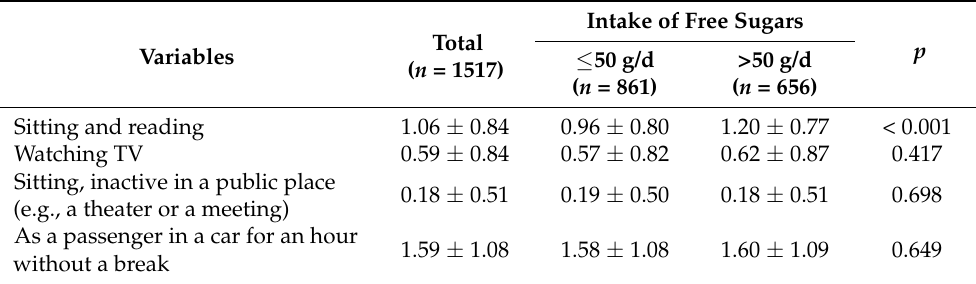
Table A4. The scores of each Epworth Sleepiness Scale item by the level of free sugars intake ( n = 1517, mean ±